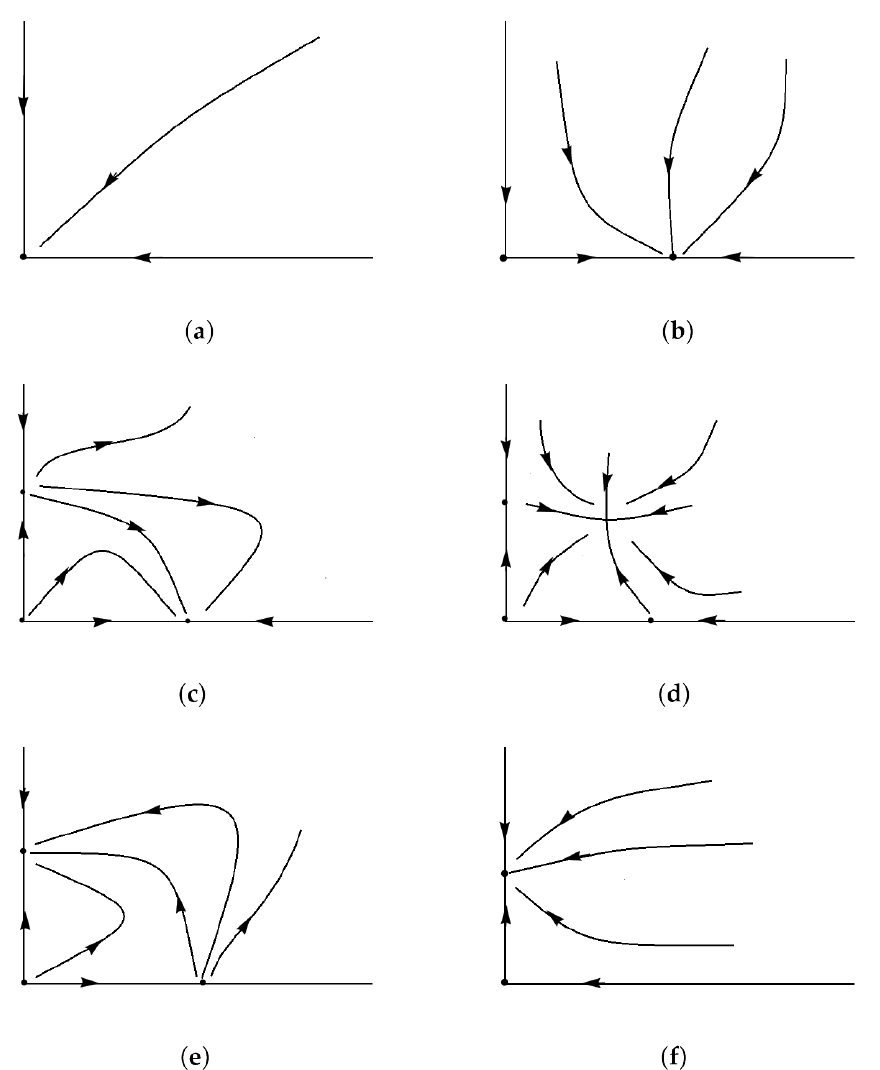
Figure 7. Bifurcation sets of the solutions derived from the double Hopf bifurcation in the c 1 − c 2 plane. ( a ) Region I, ( b ) Region II, ( c ) Region III, ( d ) Region IV, ( e ) Region V, ( f ) Region VI in Figure 6,